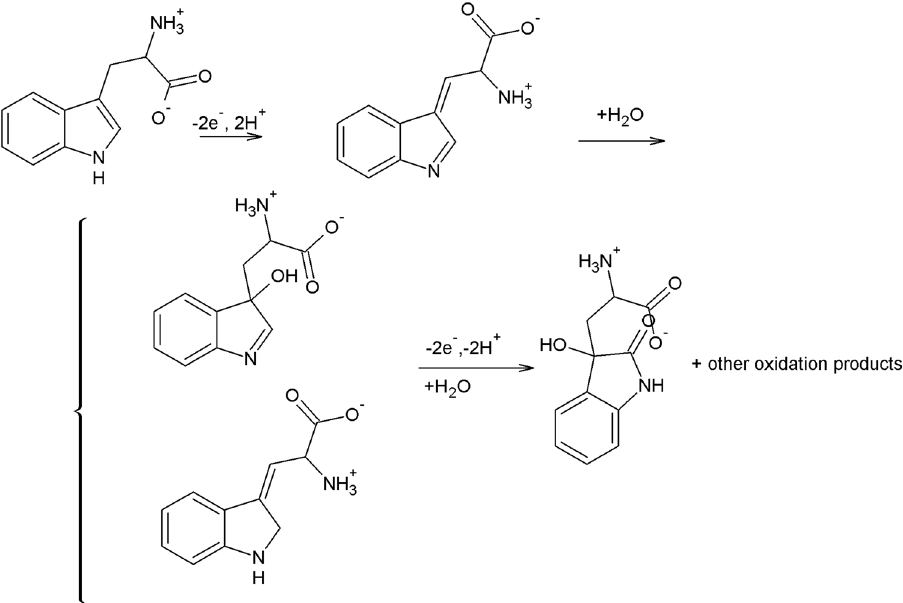
Figure 3. Mechanism of L-tryptophan